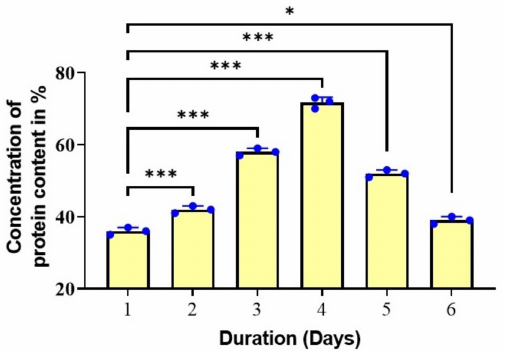
Figure 6. Estimation of protein content of the isolated Spirulina sp. The graph shows the concentration of protein of the isolated strains at different days of cultivation of Spirulina sp. * p < 0.05 and. *** p < 0.001 The student’s t -test was used for comparison.